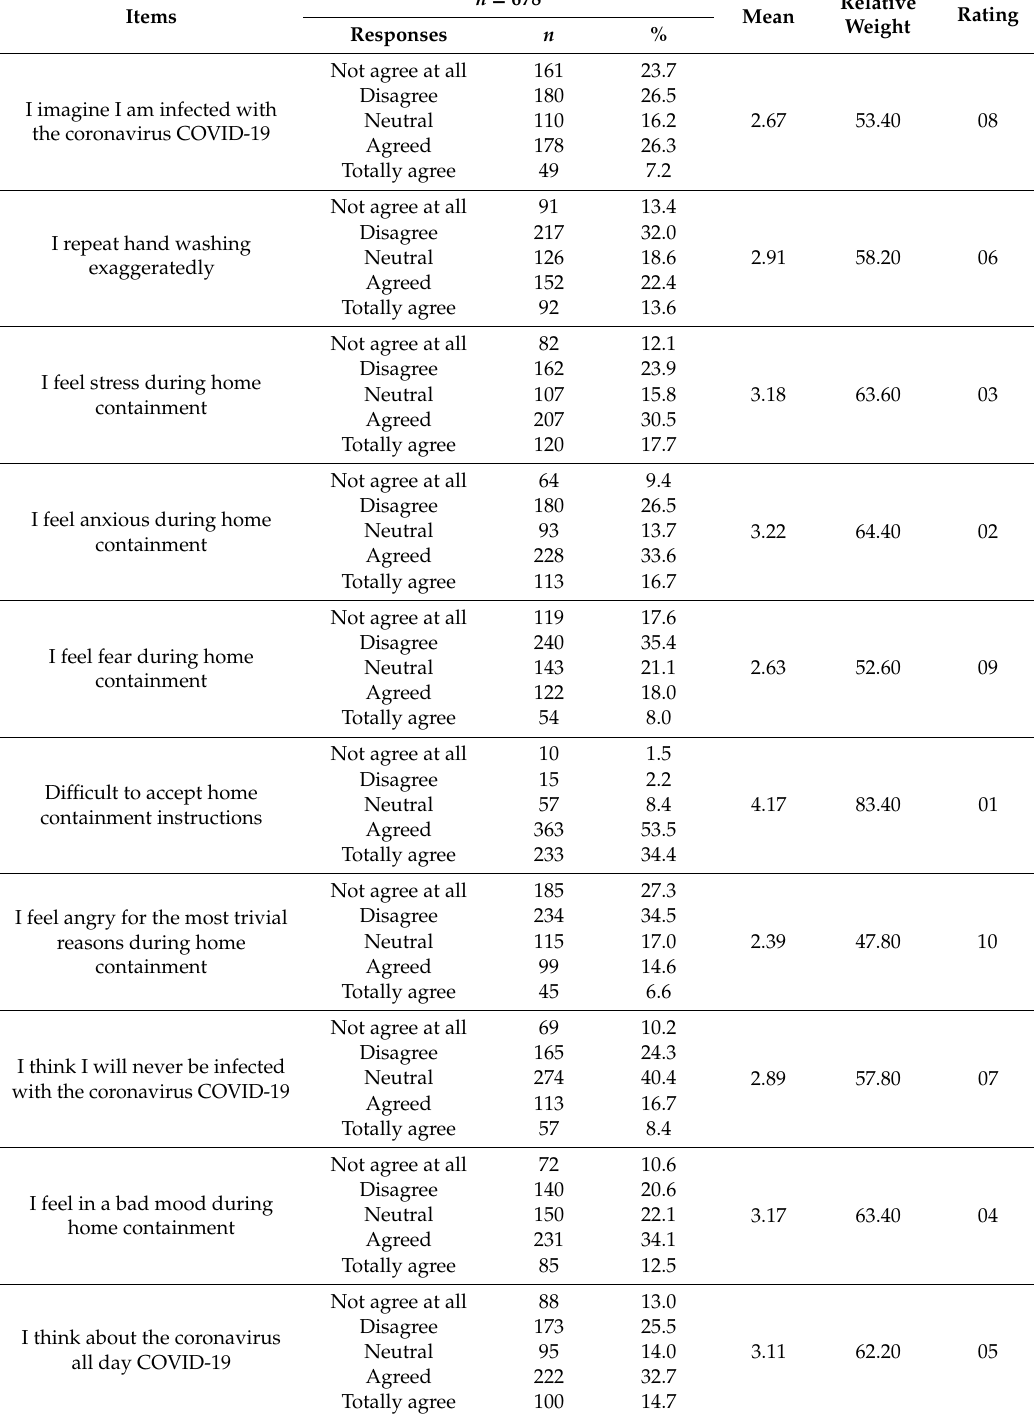
Table 5. The relative weight of the items in the questionnaire on the psychological impact of the. coronavirus epidemic COVID-19 in Algeria during the first total and partial confinement ( n = 678). n = 678 Relative Rating Mean Items Weight Responses n